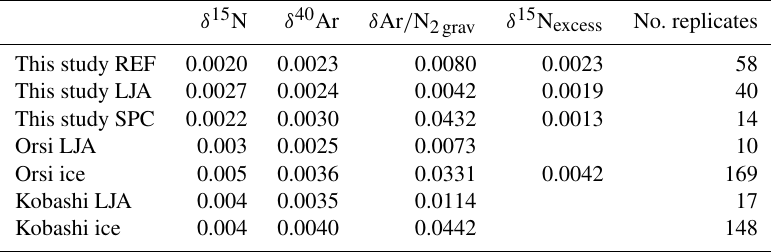
Table 1. Mass-normalized pooled standard deviation of replicate measurements of δ 15 N, δ 40 Ar, δ Ar / N 2grav , and δ 15 N excess from either reference gas runs (REF), La Jolla air flask samples (LJA), South Pole ice core samples (SPC), or other ice core samples. Units for all four isotope ratios are per mil per atomic mass unit (‰amu − 1 ), and the mass differences are 1, 4, 12, and 1amu respectively. The final column indicates n , the number of samples used in the